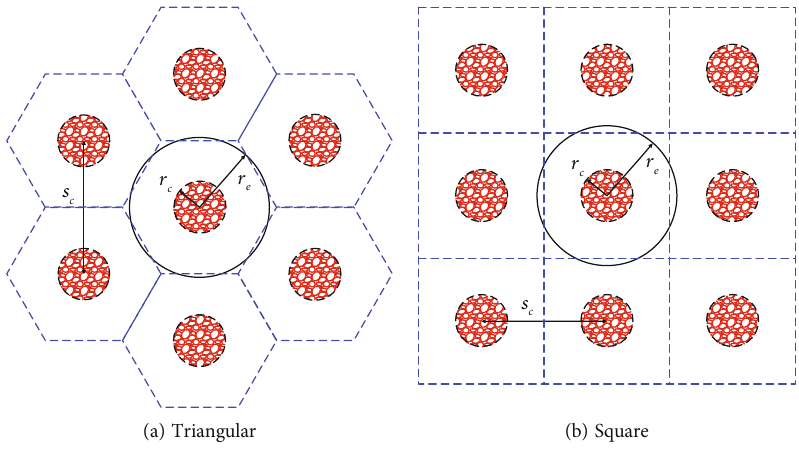
Figure 1: Layout of stone columns. Table 1: Microscopic properties of aggregate.